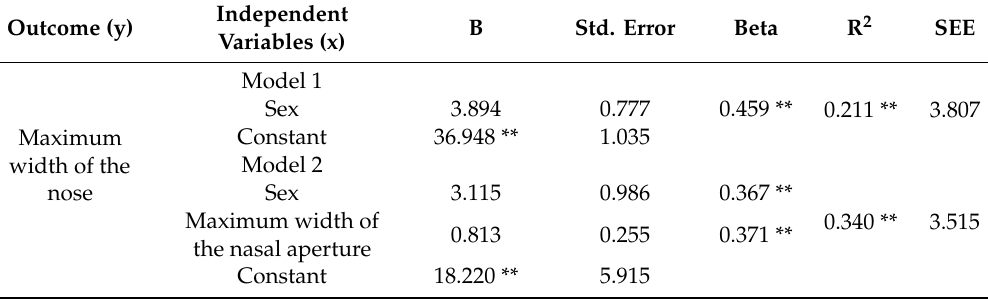
Table 4. Regression model for maximum width of the nasal aperture and sex for maximum width of the